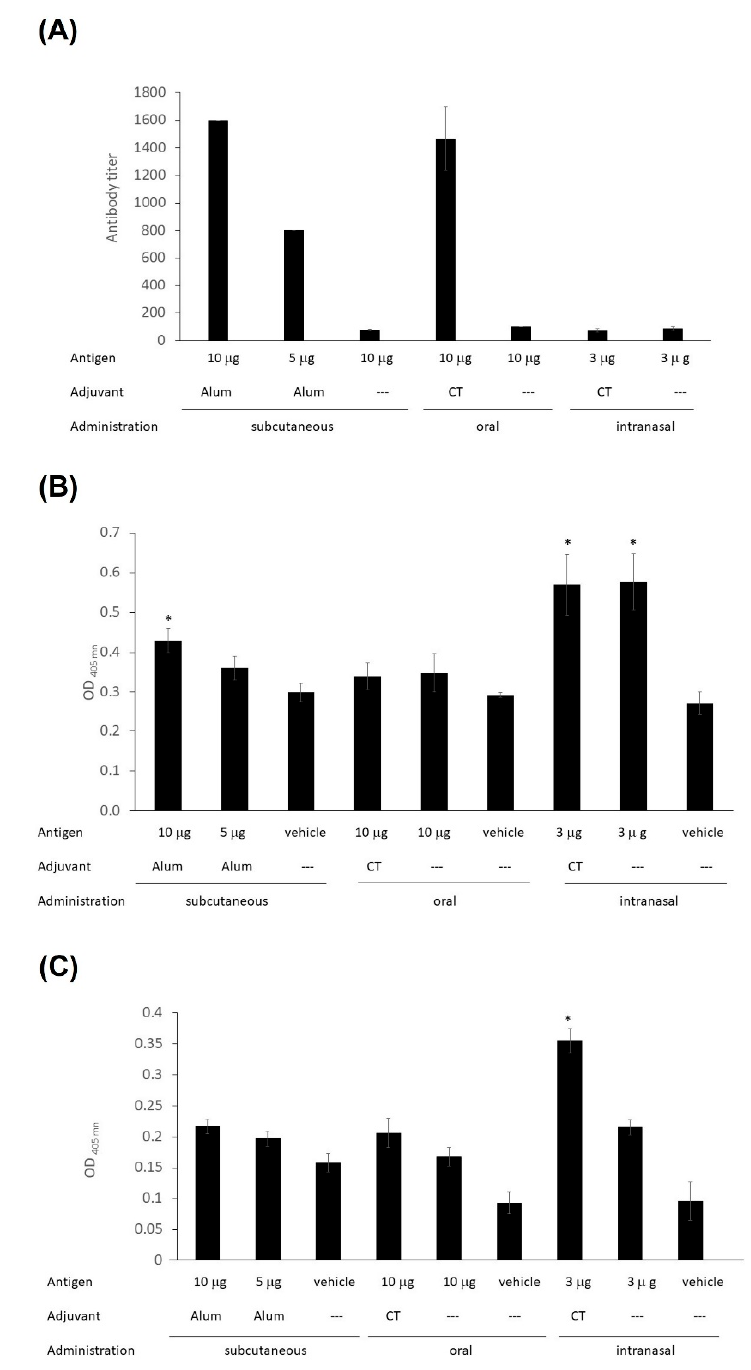
Figure 10. Humoral response induced by LTB-RBD in test mice. ( A ) IgG titers measured in serum. ( B ) IgA levels measured in mouth washes. ( C ) IgA levels measured in feces. Antibodies were measured by ELISA using the S protein as the target antigen. Samples were collected on day 27. The error bars are the standard deviation of the mean absorbance value. Asterisks denote significant differences ( p < 0.05) versus the control group (vehicle).